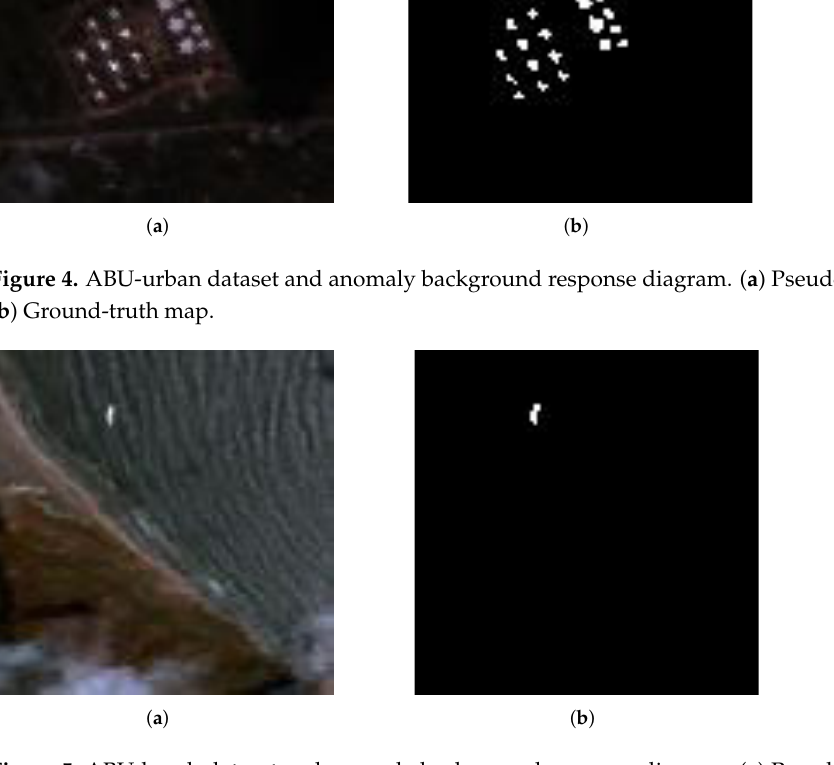
Figure 5. ABU-beach dataset and anomaly background response diagram. ( a ) Pseudo-color image. ( b ) Ground-truth map.